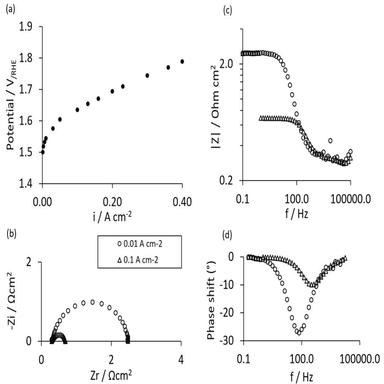
A) OER polarization curve of a nickel plate electrode in a three electrode laboratory setup operating with 6 M KOH at room temperature; b) Nyquist plots for 0.01 and 0.1 A cm− 2 ; c) and d) Bode plots showing the dependence of absolute impedance and phase shift on the frequency for 0.01 and 0.1 A cm− 2 . Description of the three electrode beaker type laboratory setup can be found in.